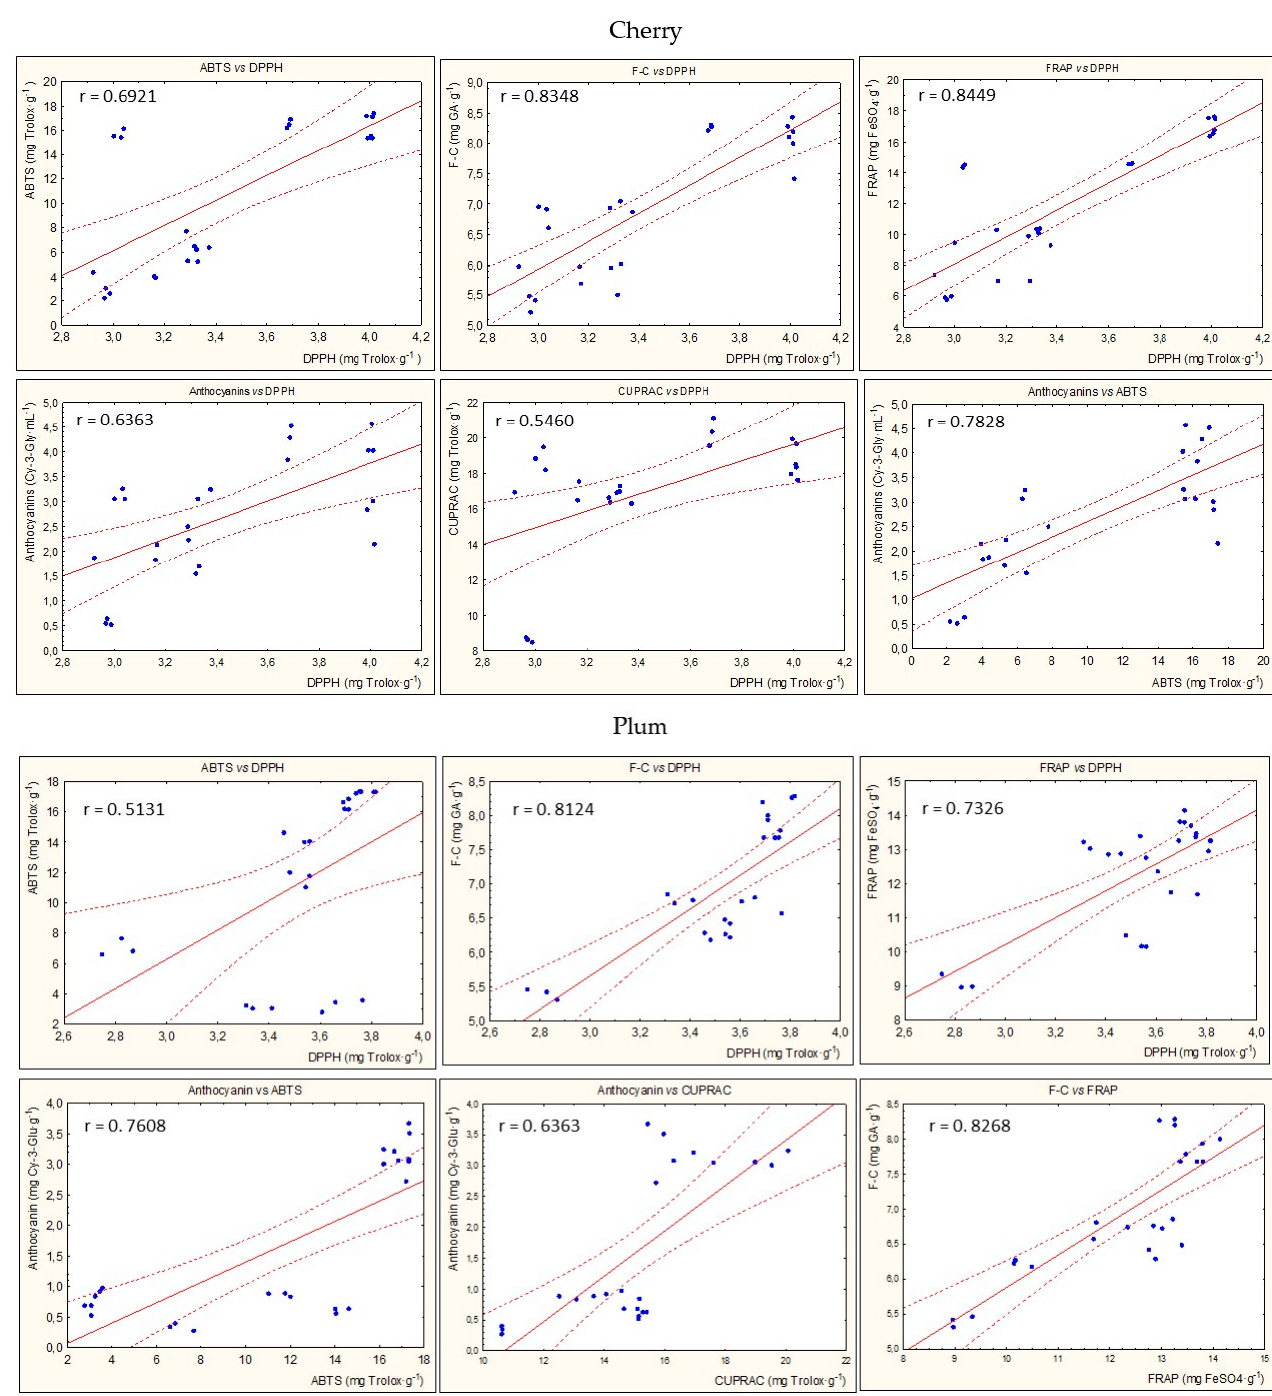
Figure 8. Examples of the statistically significant correlations (r) between parameters of antioxidant activity for all nalewkas; p < 0.05.